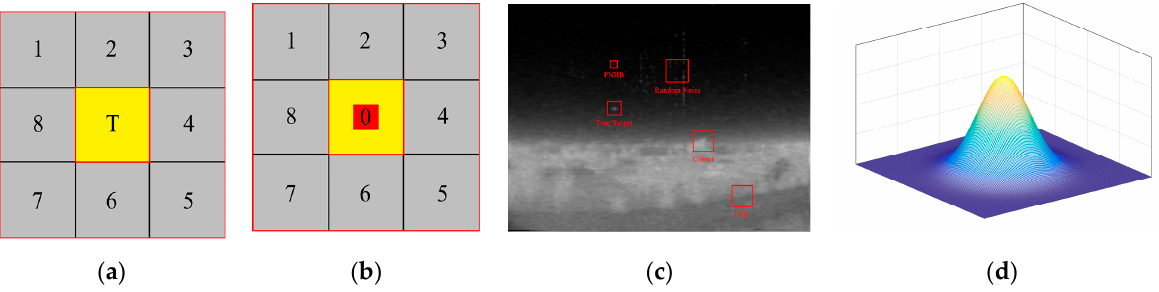
Figure 1. ( a ) Double-nested detection window. ( b ) Improved double-nested detection window. ( c ) Situations that the algorithm needs to handle. ( d ) Gaussian shape.